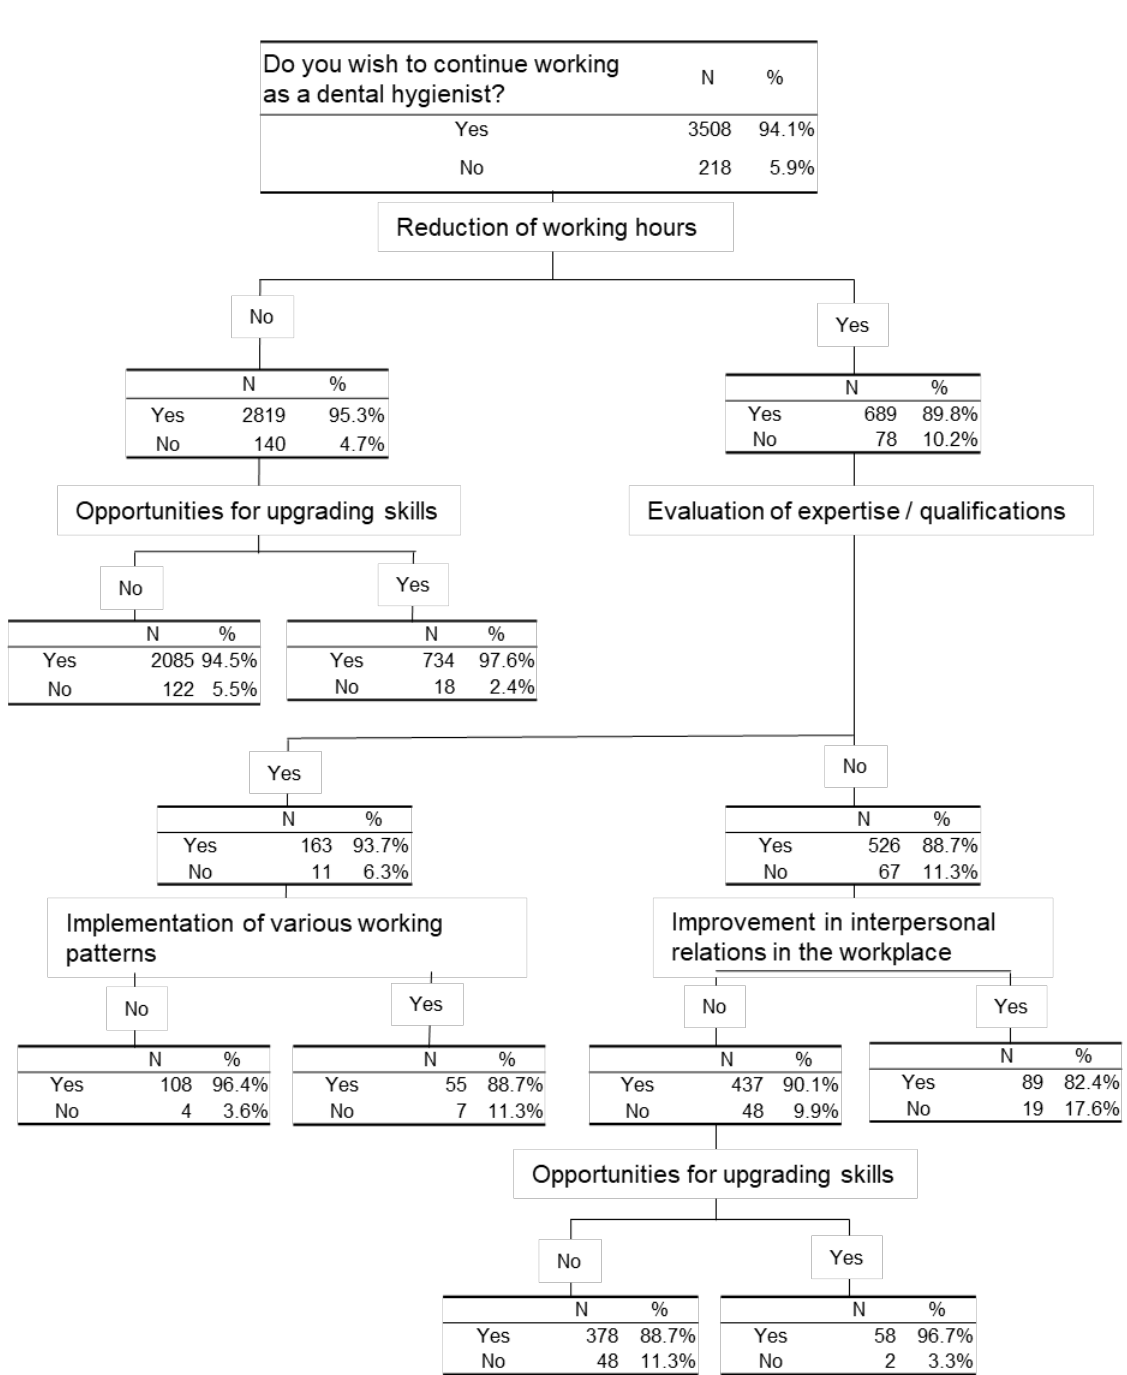
Figure 3. A decision tree to identify subjects who answered “No” for the item of “Do you wish to continue working as a dental hygienist?